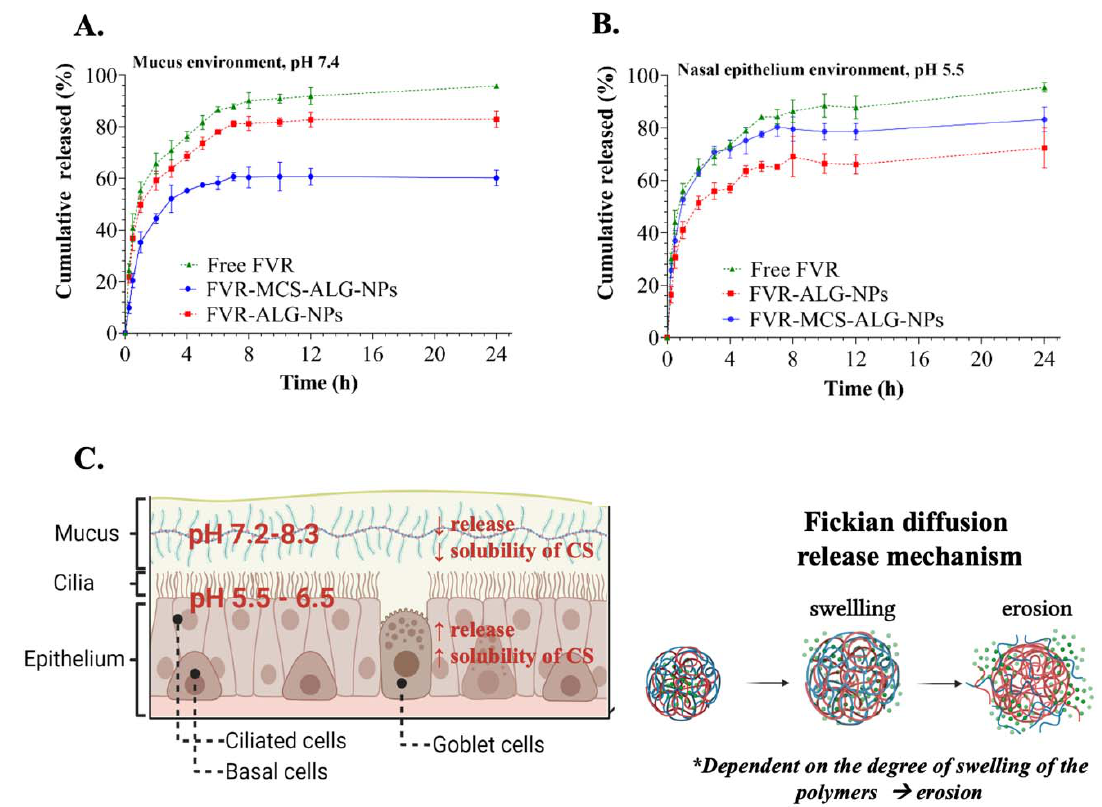
Figure 4. In vitro FVR released from NPs in the ( A ) mucus and ( B ) nasal epithelium environment ( n = 3) through SnakeSkin™ artificial membrane; ( C ) illustration of the proposed release mechanism of FVR from the MCS-ALG-NPs.